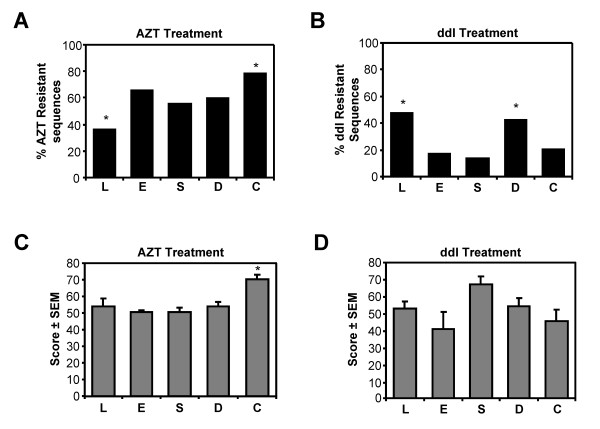
Analysis of the effects of AZT and ddI treatment on drug-resistance in esophagus (E), stomach (S), duodenum (D), colon (C) and PBL (L). Resistance mutations were recorded and scored using the Stanford Drug-Resistance Database for level of drug-resistance. Sequences with intermediate to high-level resistance for AZT, or ddI were considered drug-resistant. The number of drug-resistance sequences recovered after AZT (A) or ddI (B) treatment in each tissue was expressed as the percentage of all sequences recovered from the tissue. Different numbers of AZT and ddI resistant sequences were found in the gut tissues and PBL following AZT treatment and ddI treatment, respectively (* p < 0.05, Pearson chi-square test)
The average drug-resistance score for each drug also varied in each tissue. AZT drug resistance scores were the highest in the colon following AZT treatment (C). However, ddI resistance scores did not differ significantly in the different tissues following ddI treatment (D). These observations are consistent with differential distribution of antiretroviral drug-resistance in the gut, and indicated that the AZT and ddI treatment affected each tissue differently (* p < 0.05, Tukeys HSD post-hoc analysis).